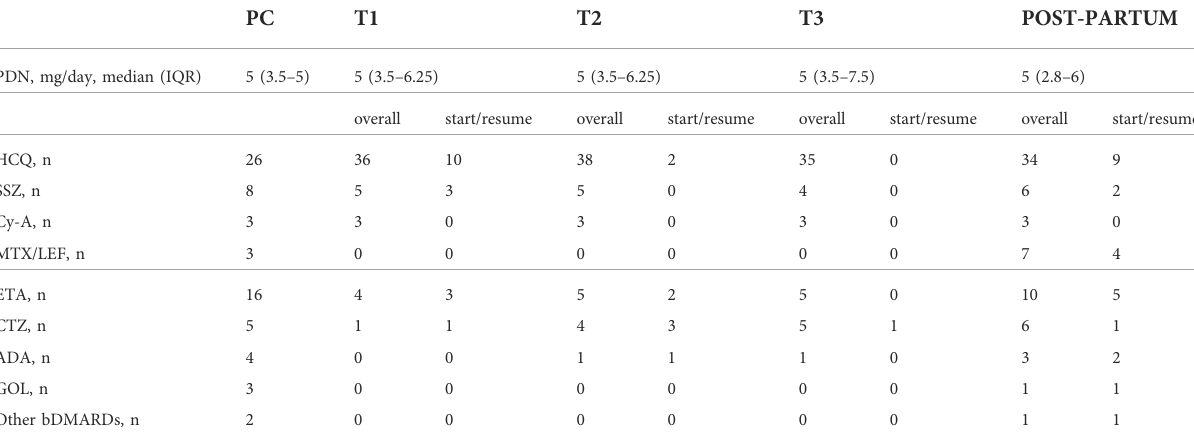
TABLE 2 Overall exposure to anti-rheumatic drugs and changes of treatment during pregnancy and post-partum period (numbers refer to patients on treatment at each time point).